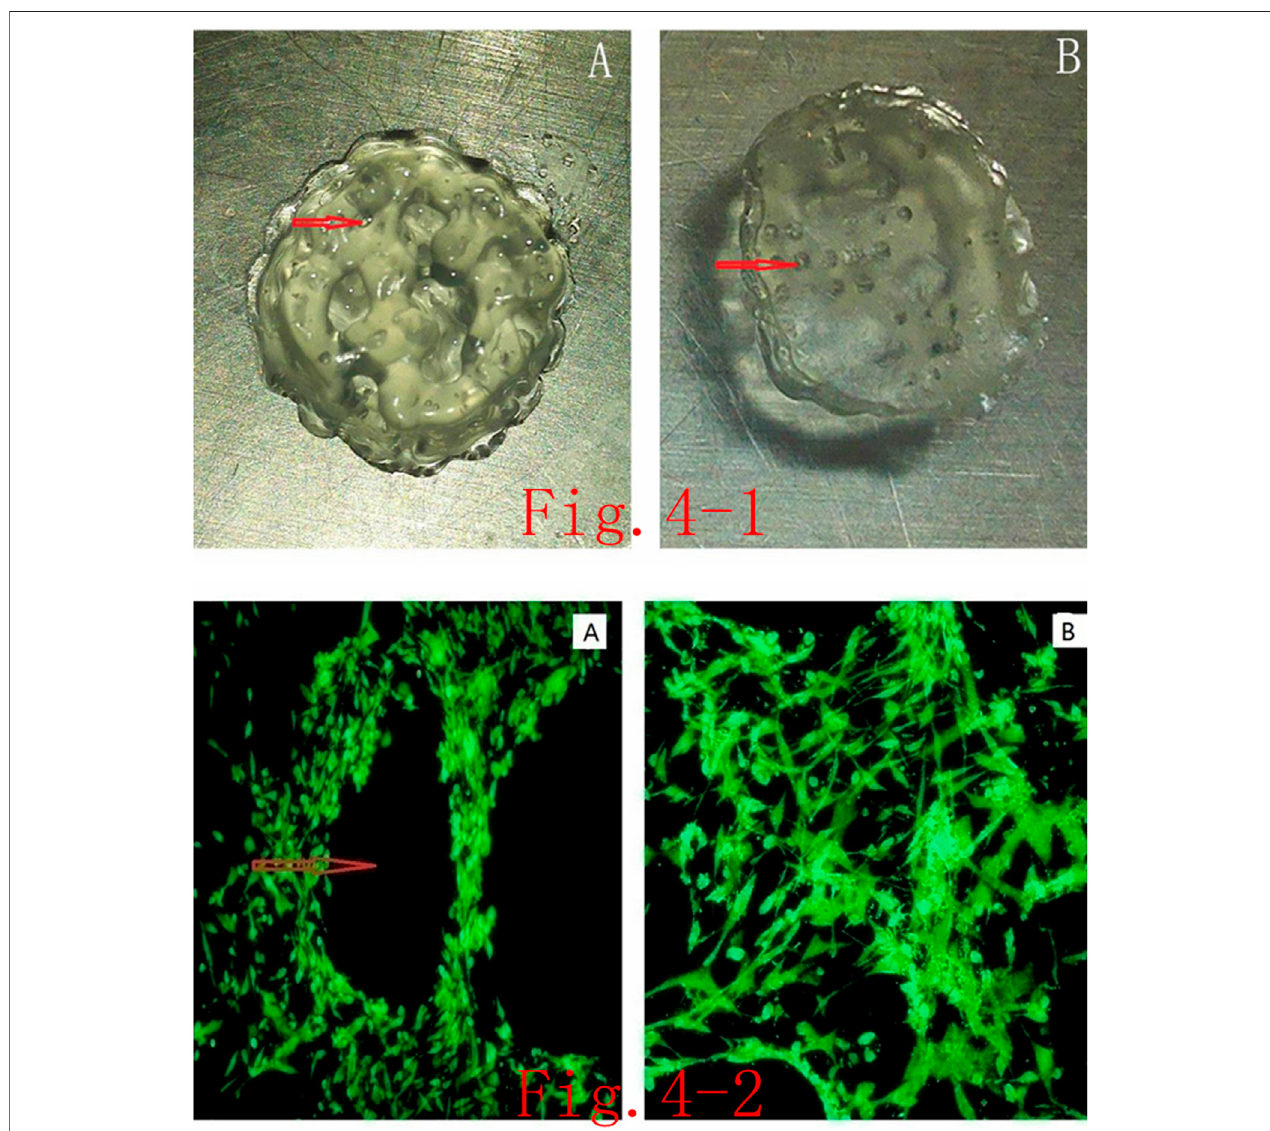
FIGURE4|(i) .3D-printedtissuemodelbasedonself-assemblednanopeptides andAdiposeTissue – DerivedMesenchymalStemCells(Ad-MSCs): (A) :Frontside of the 3D-printed model, revealing that it is not a regular cylindrical structure and there are pore-like structures as designed by the software. The red arrow in the fi gure points to the pore (the diameter of the cylinder is 1 cm). On the reverse side of the 3D model, a pore-like structure is still visible (the diameter of the cylinder is 1 cm). (ii) . Phalloidin staining of cells in a 3D-printed tissue model: (A) : After the 3D-printed model was sectioned and stained, the internal structure was observed by fl uorescence microscopy. Red arrows point to pore-like structures ( × 40). (B) : After the 3D-printed model was sectioned and stained, fl uorescence microscope observationoftheintervalstructureshowsthatthecellsarearrangedinanintricateandtightmanner( × 40). (iii) .AlizarinredSstainingafterosteogenicinductionofcellsin the 3D-printed model: (A) : Alizarin red S staining was performed on the Ad-MSCs in the 3D-printed models after osteogenic differentiation and sectioning. Cells were densely packed with red calcium nodule precipitation ( × 40). (B) : The model without induction of differentiation. Ad-MSCs show no obvious staining ( × 40). (iv) . Oilred O staining of cells in the 3D-printed model after adipogenic differentiation: (A) : After adipogenic differentiation of Ad-MSCs in the 3D-printed model, oil red O staining was performed after sectioning. Red lipid droplets are seen in the cells ( × 40). (B) : Oil red O staining on cells in the models with no adipogenic differentiation. No obvious staining is seen ( × 100). (v) . Induced endothelial differentiation of cells in the 3D-printed model and immunophenotyping via fl ow cytometry: (A) : Induction of endothelial differentiation of Ad-MSCs in the 3D-printed model. Cells demonstrate paving stone – like changes ( × 100). (B) : CD31-negative expression in the control group. (C) : CD31-positive expression in the experimental